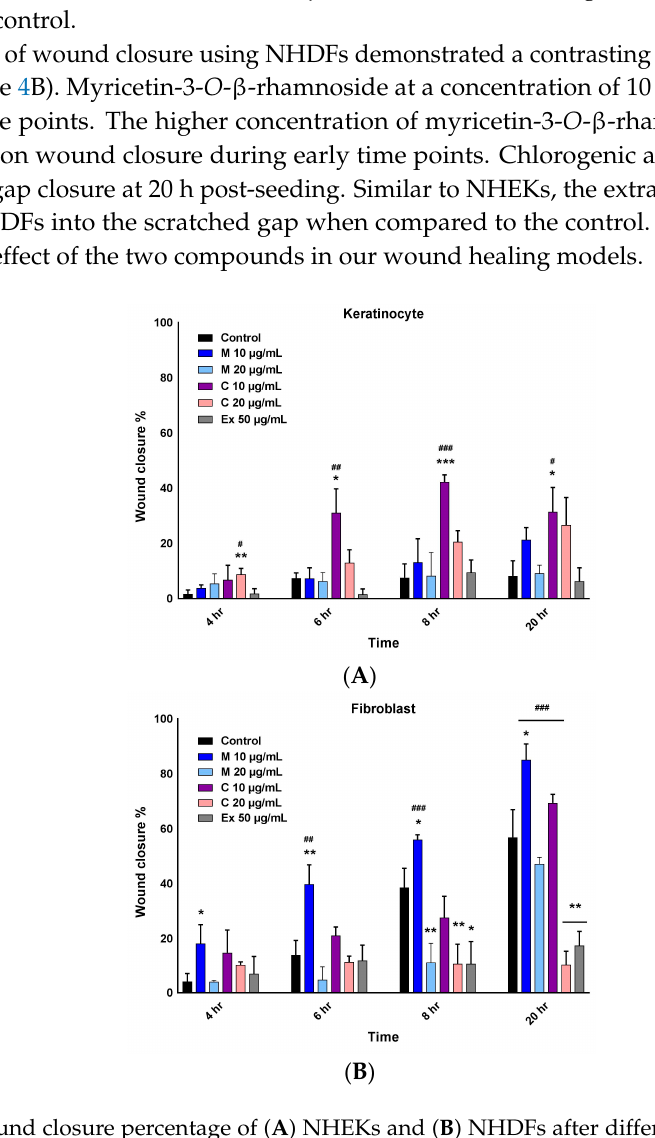
Figure 4. Wound closure percentage of ( A ) NHEKs and ( B ) NHDFs after different time intervals of exposure to different concentrations of the natural compounds, as measured using a scratch assay.